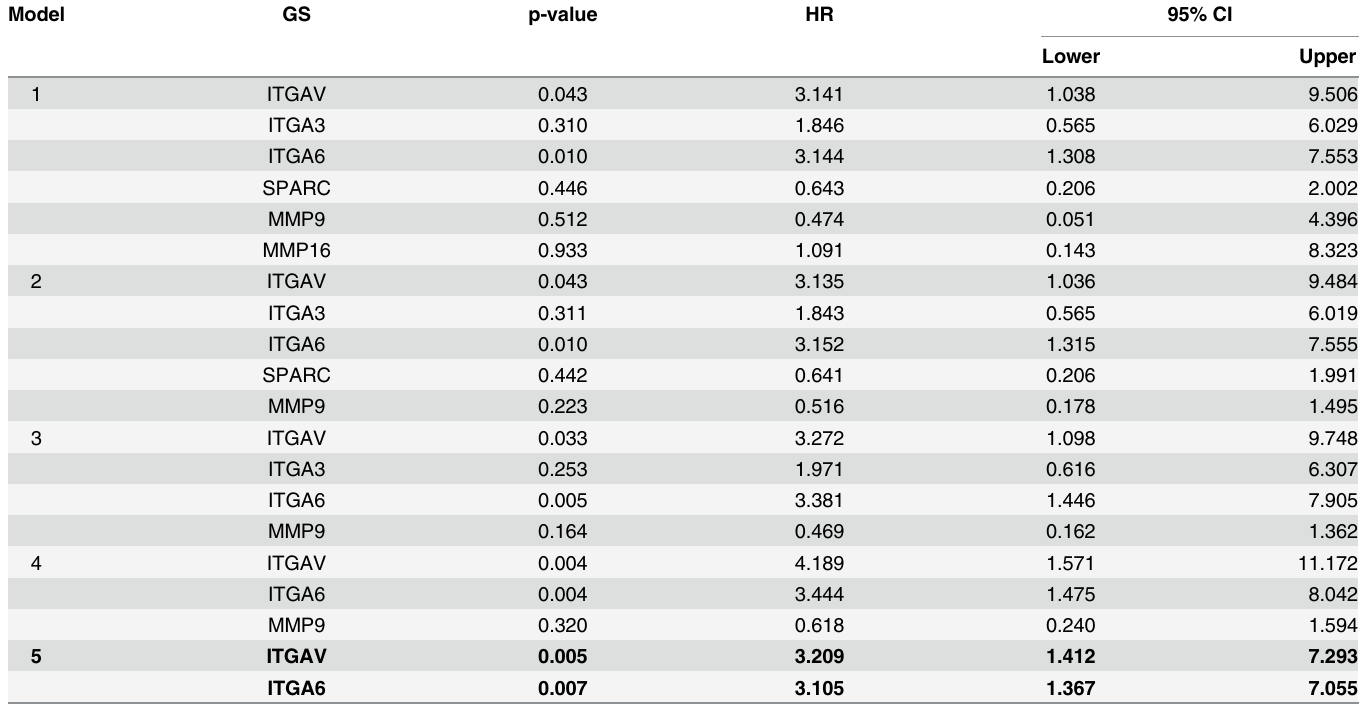
Table 3. Stepwise Cox regression models for GS using hyperexpression of the markers detected.